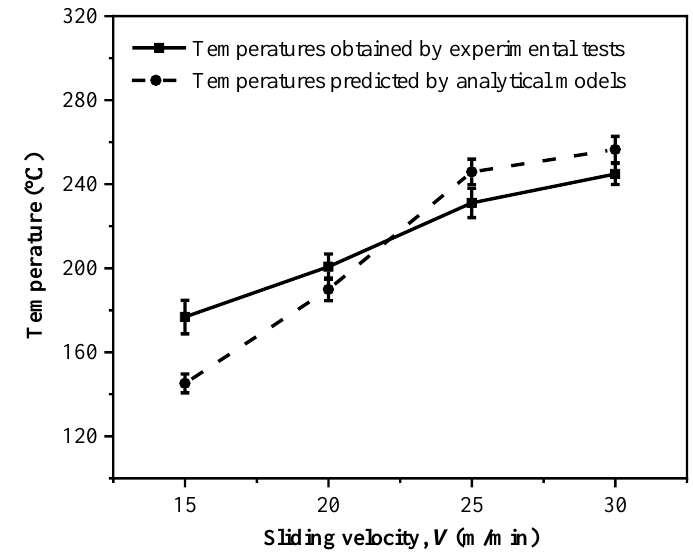
Figure 8. Comparison of the drilling temperatures of the tool-work interface gained by the experimental tests and analytical models at a constant feed rate ( f ) of 0.02 mm/rev.